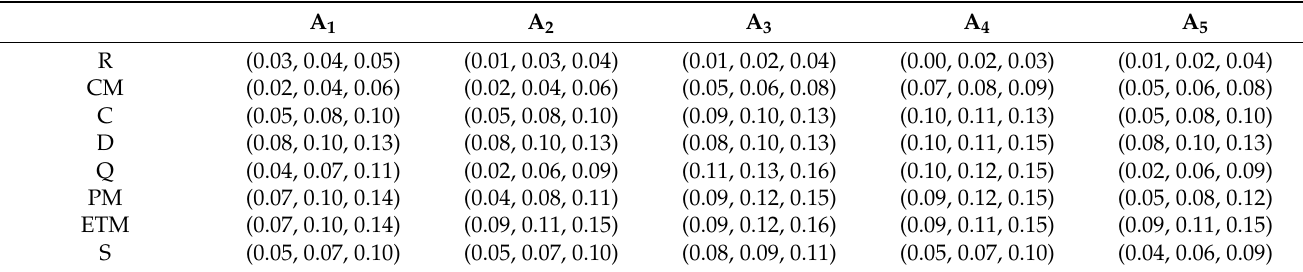
Table 8. Weighted normalised decision matrix.